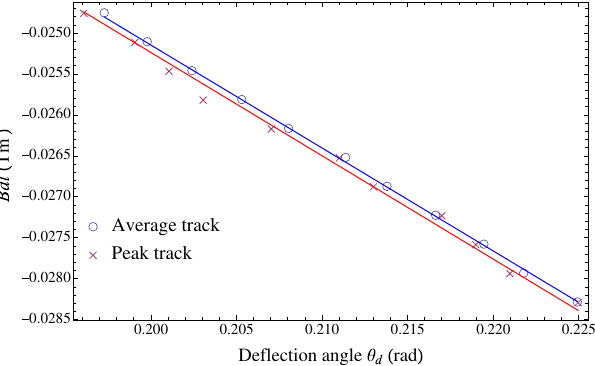
FIG. 26. Like in Fig. 12, the circles are the data points when the mean of the distribution is tracked and crossed symbols data points are when the peak of the distribution is tracked.